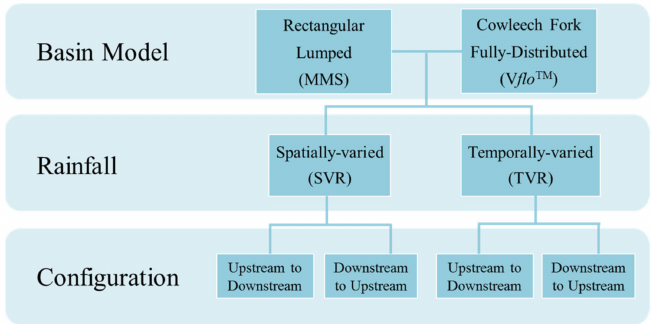
Figure 1. Research investigation workflow.